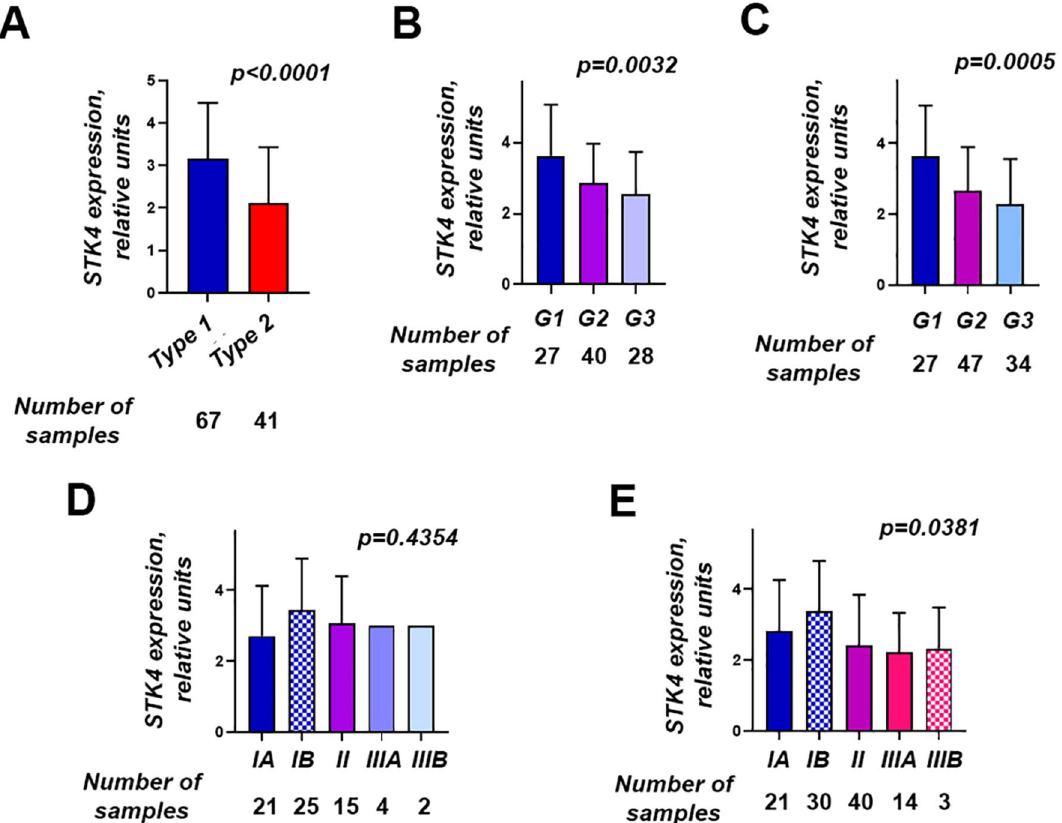
Figure 2. STK4 protein expression in relation to tumor clinicopathological characteristics. The Kruskal-Walli’s test was applied in all cases with respective exact p-values reported in the figure. ( A ) STK4 is expressed at higher levels in Type 1 tumors, than in Type 2 samples; ( B ) STK4 protein levels are decreasing with the advanced tumor grade; ( C ) This observation (in B ) became more clear when serous tumors were included in statistical calculations; ( D ) No significant differences were observed in SKT4 expression, when it was related to the tumor stage; ( E ) A slight decrease in STK4 expression upon tumor progression was detected, when serous tumors were included in